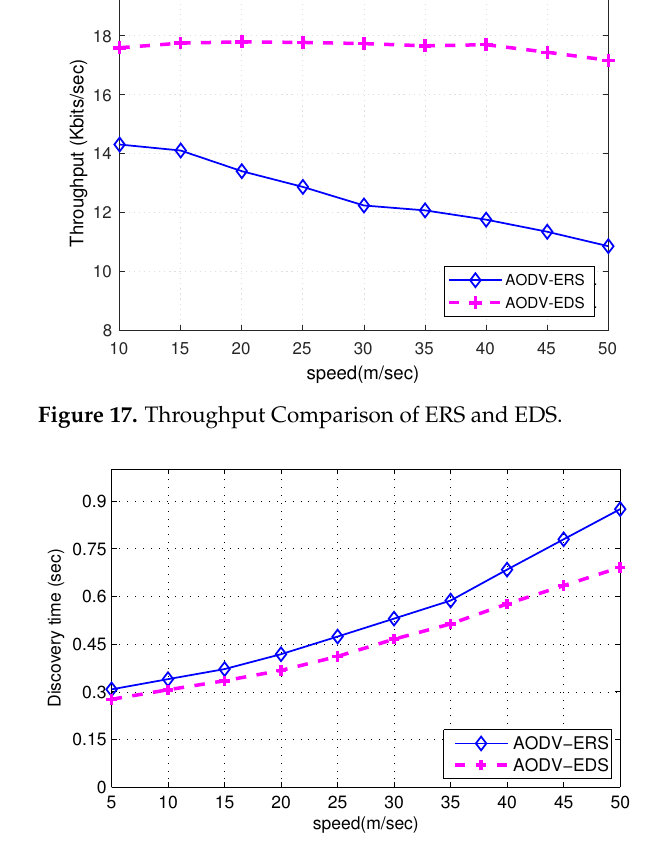
Figure 18. Latency Comparison of ERS and EDS. Table 5. Performance comparison of EDS with other route discovery